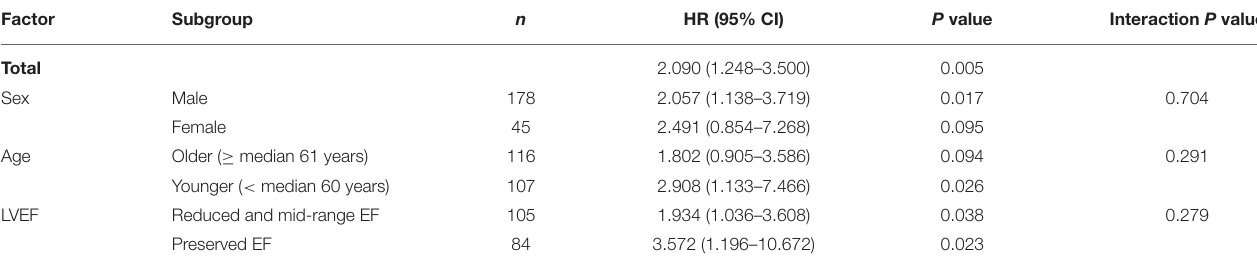
TABLE 6 | Cox proportional hazard model for cardiac events: the impact of high CAVI (Sub-group analysis).